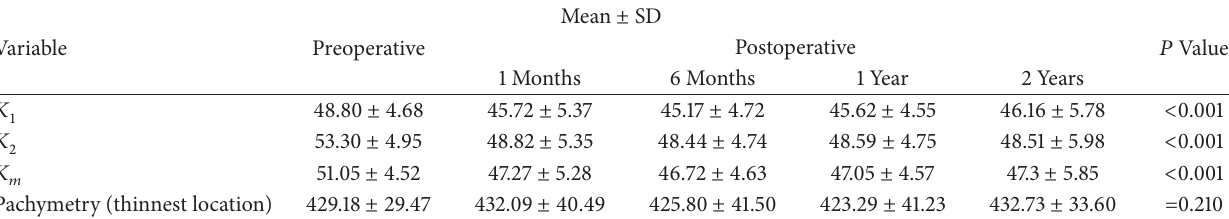
Table 2: Keratometry (D) and pachymetry ( 𝜇 m) over